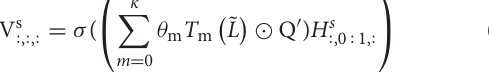
to one. The spatial ensemble attention operation is presented by ( Figure 4